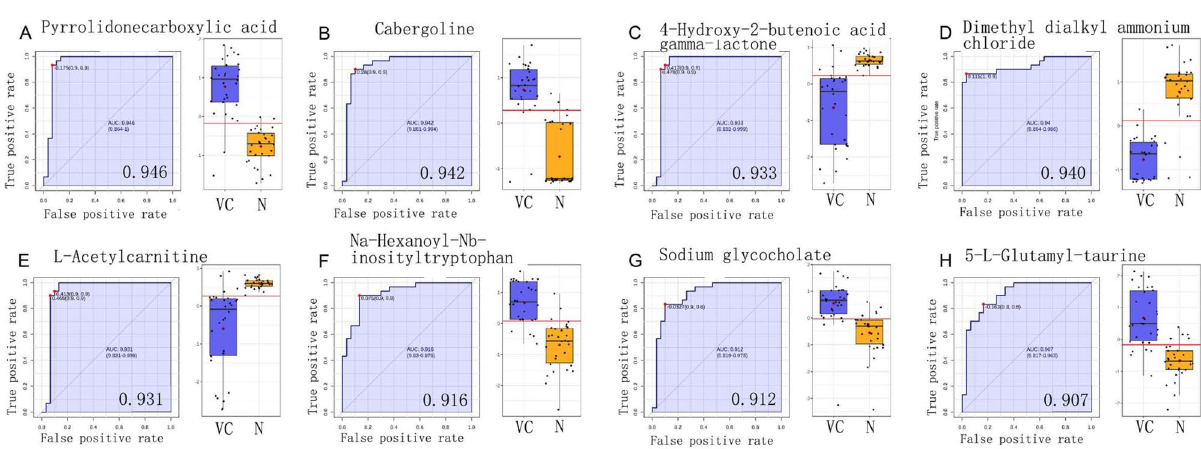
Figure 4. Potential biomarker analysis. The horizontal axis shows the false positive rate (= 1-specificity). The vertical axis shows true positive rate (= sensitivity).AUC = area under curve; N: normal control group, VCL: varicocele